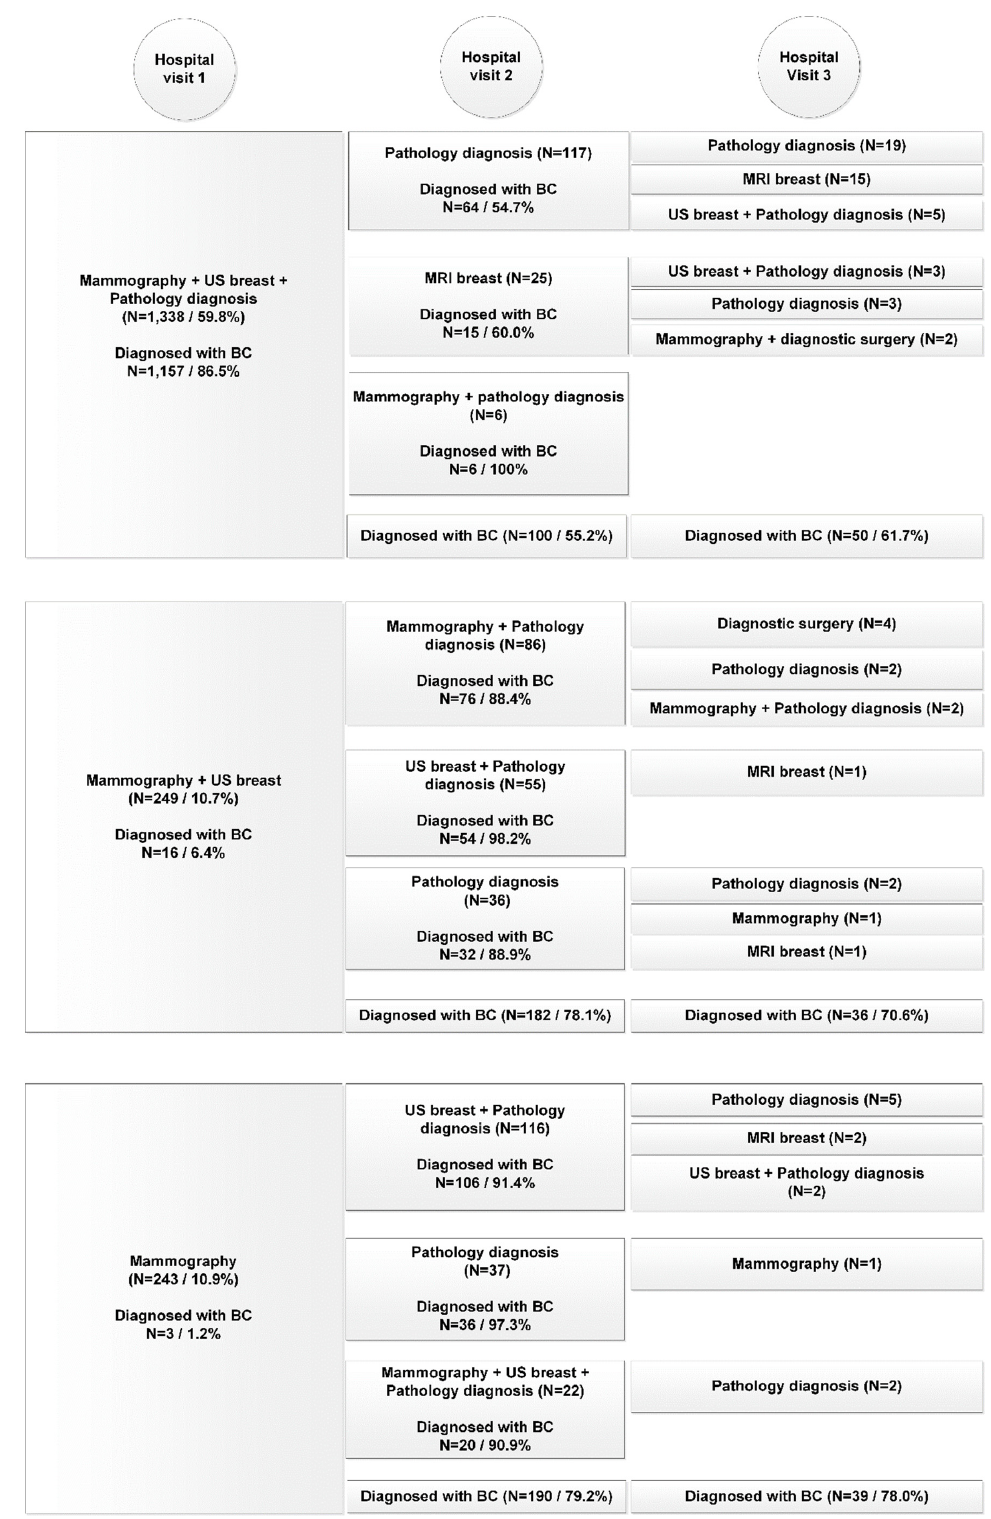
Figure 2. Diagnostic pathway per consecutive hospital visit of patients in the malignant cohort ( n = 2236). The hospital with the lowest percentage of same-day and threefold diagnostics (36.5%) was the same hospital with the highest number of days, and thus the longest diagnostics